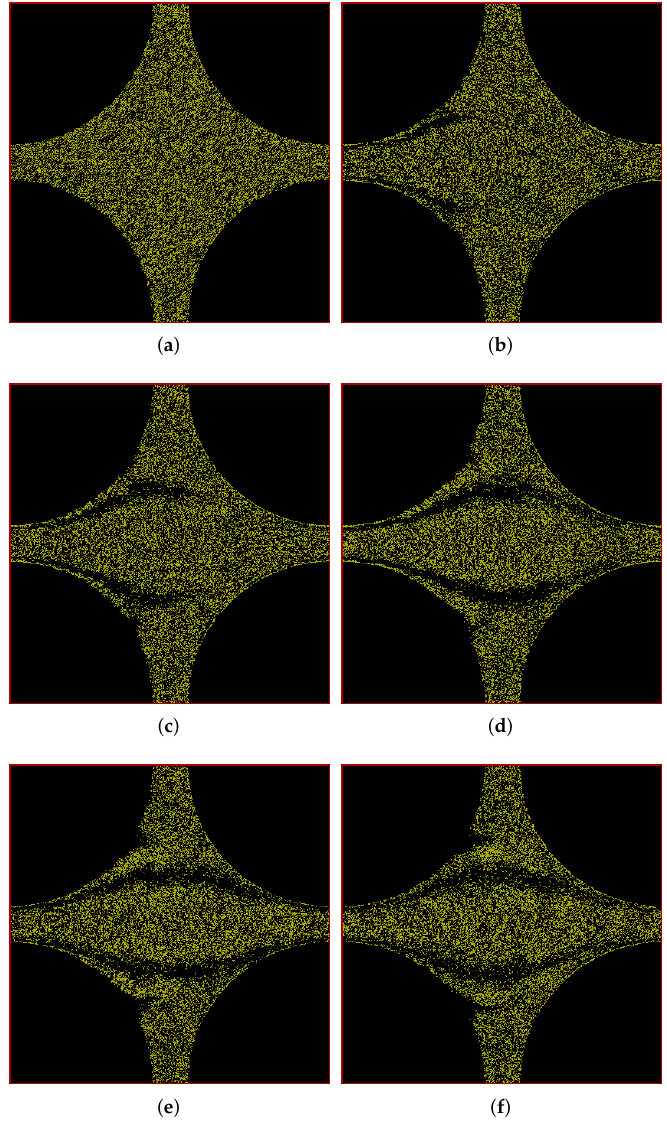
Figure 2. Snapshots of simulation (in porous-media-view) at different times showing development of polymer positions over time for flow through a cylindrical porous medium with pressure applied in the positive x -direction. ( a ) t = 0 s; ( b ) t = 25 s; ( c ) t = 50 s; ( d ) t = 100 s; ( e ) t = 150 s; ( f ) t = 200